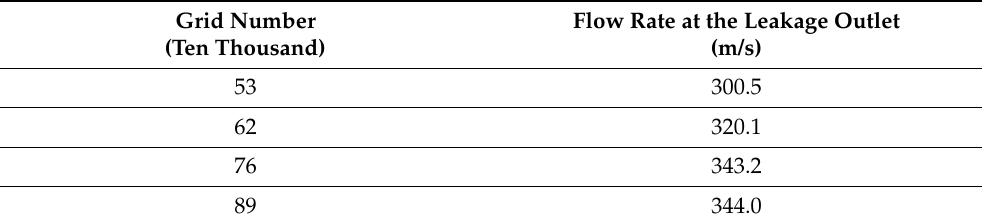
Table 3. Grid independence analysis.